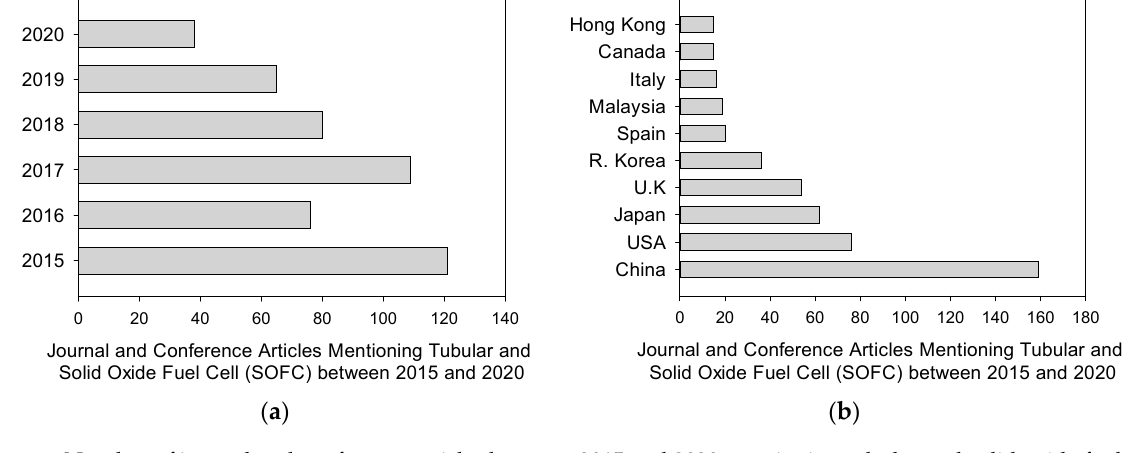
Figure 5. Number of journal and conference articles between 2015 and 2020 mentioning tubular and solid oxide fuel cells (SOFCs) from an Engineering Village search ( a ) by year and ( b ) by location.